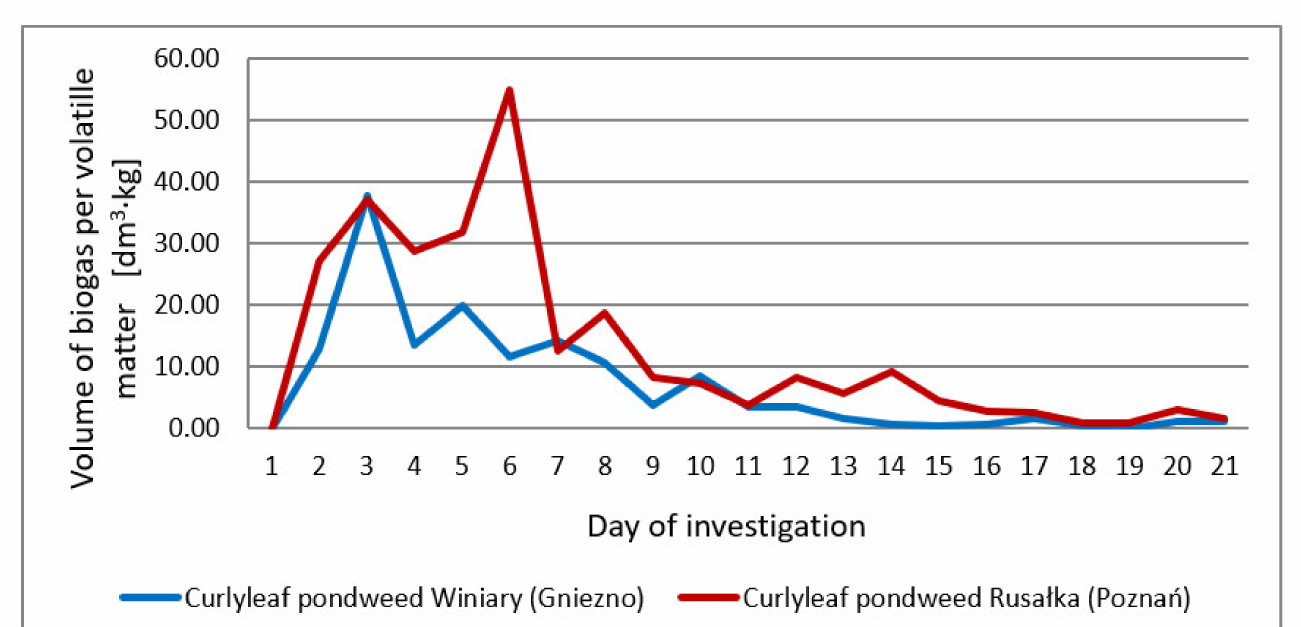
Figure 5. Graph of instantaneous biogas yield for curly-leaf pondweed per volatile matter.